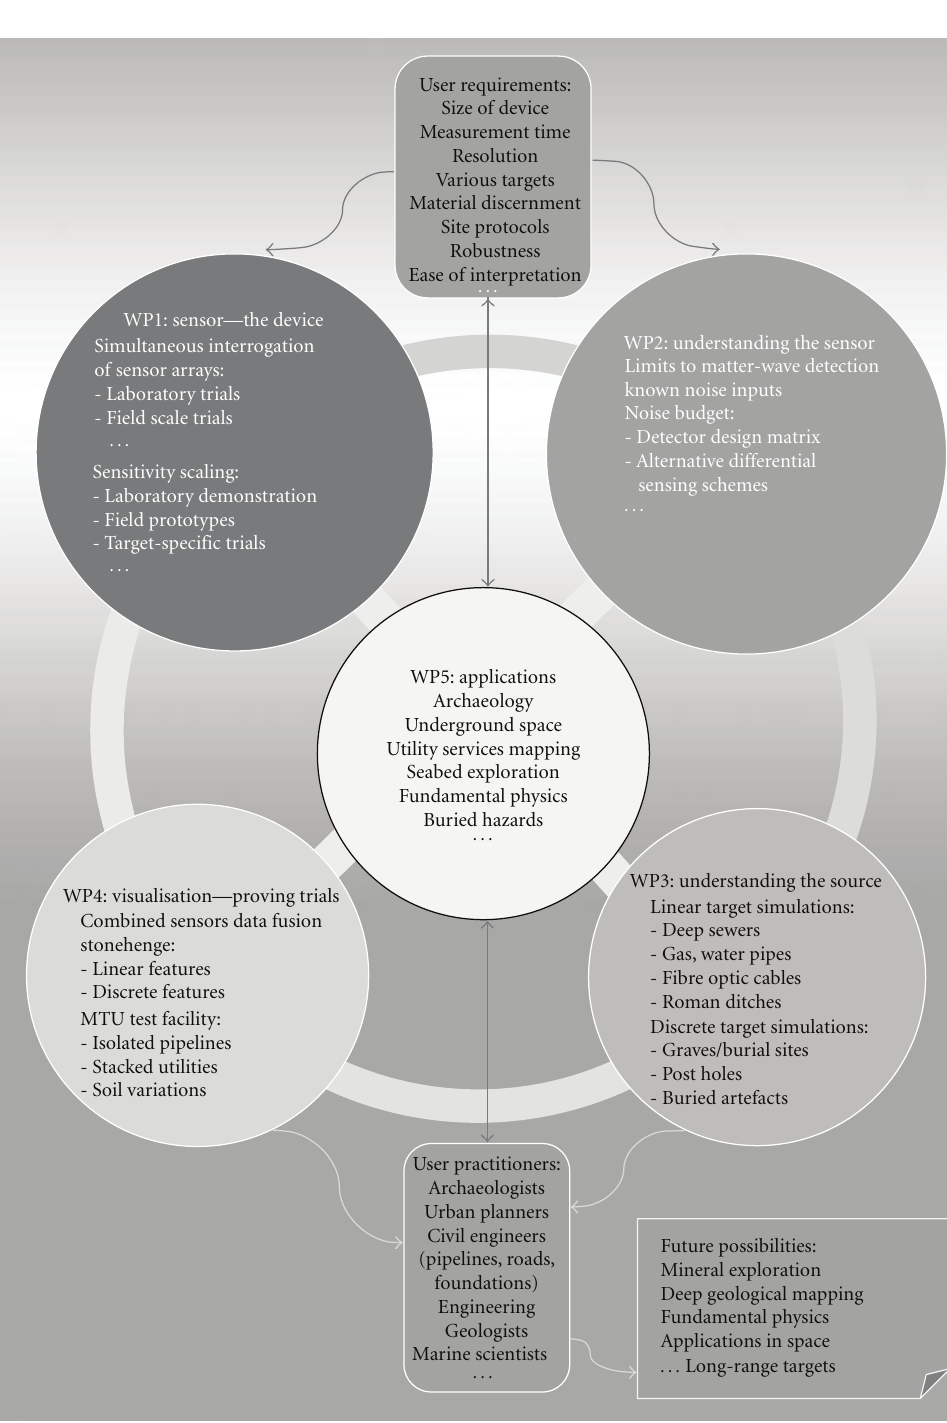
in sensitivity and usability. In addition to the